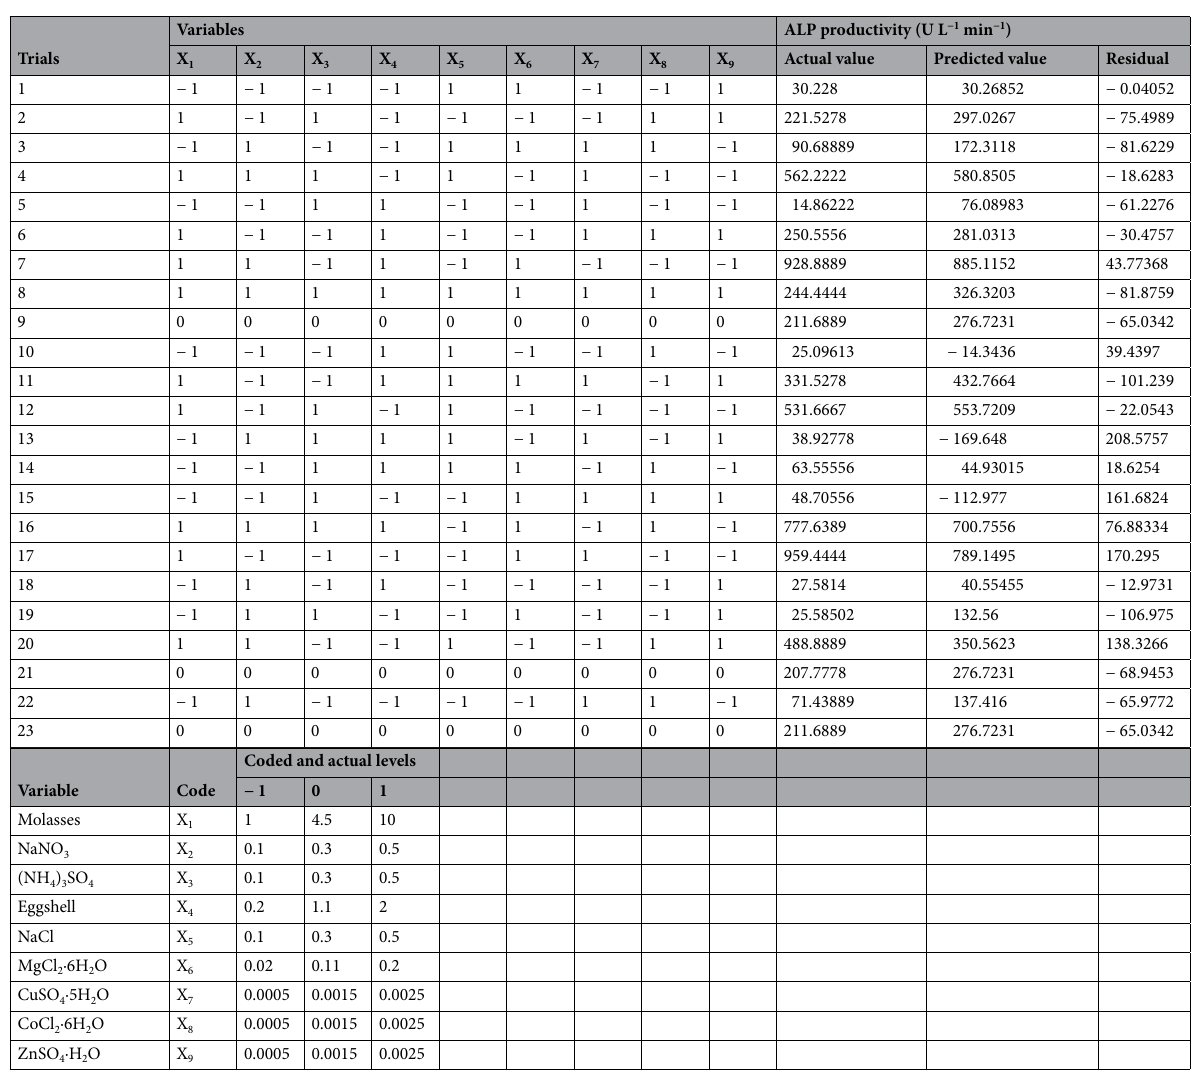
Table 1. Randomized PBD for evaluating factors influencing ALP production by Lysinibacillus sp. strain